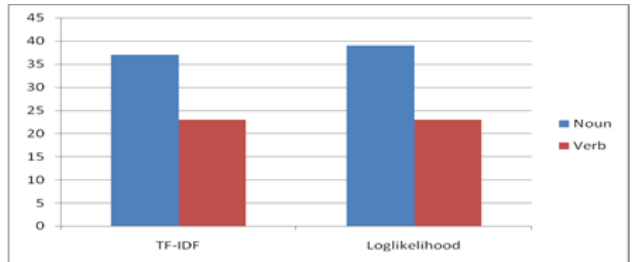
Fig. 3. Nouns and Verb in keywords extracted from the TF- IDF and Loglikelihood